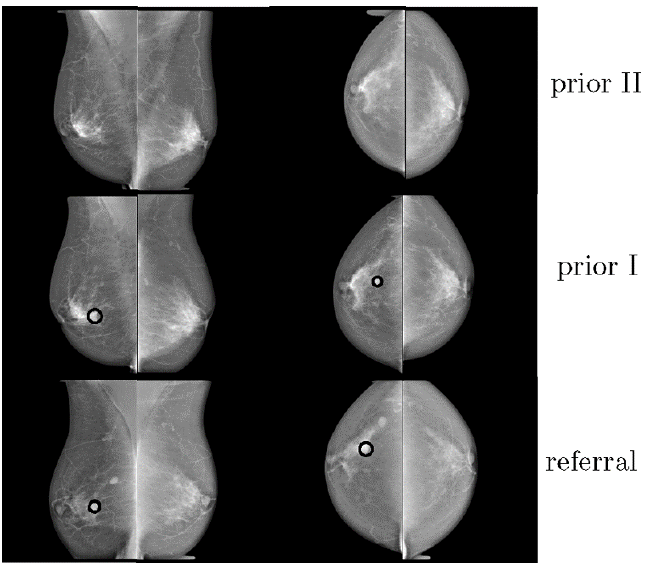
Figure 2. Example of three consecutive mammograms of the same woman. The last mammogram was from the time of referral. The other mammograms were obtained at previous screening rounds (reprint with permission from